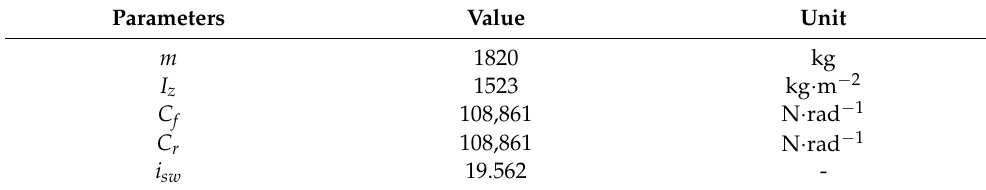
Table 3. Parameters of vehicle.